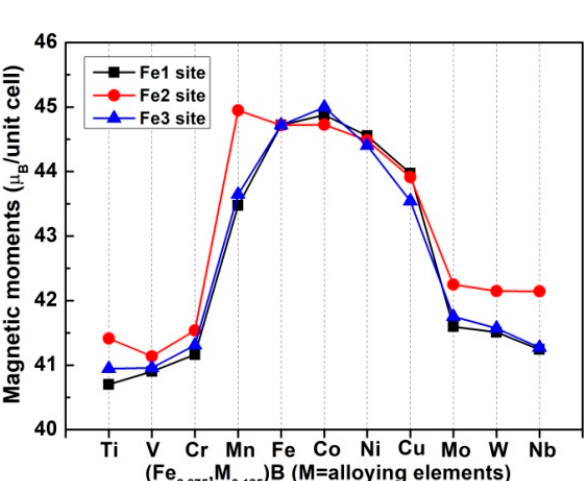
3 B and alloyed Fe 3